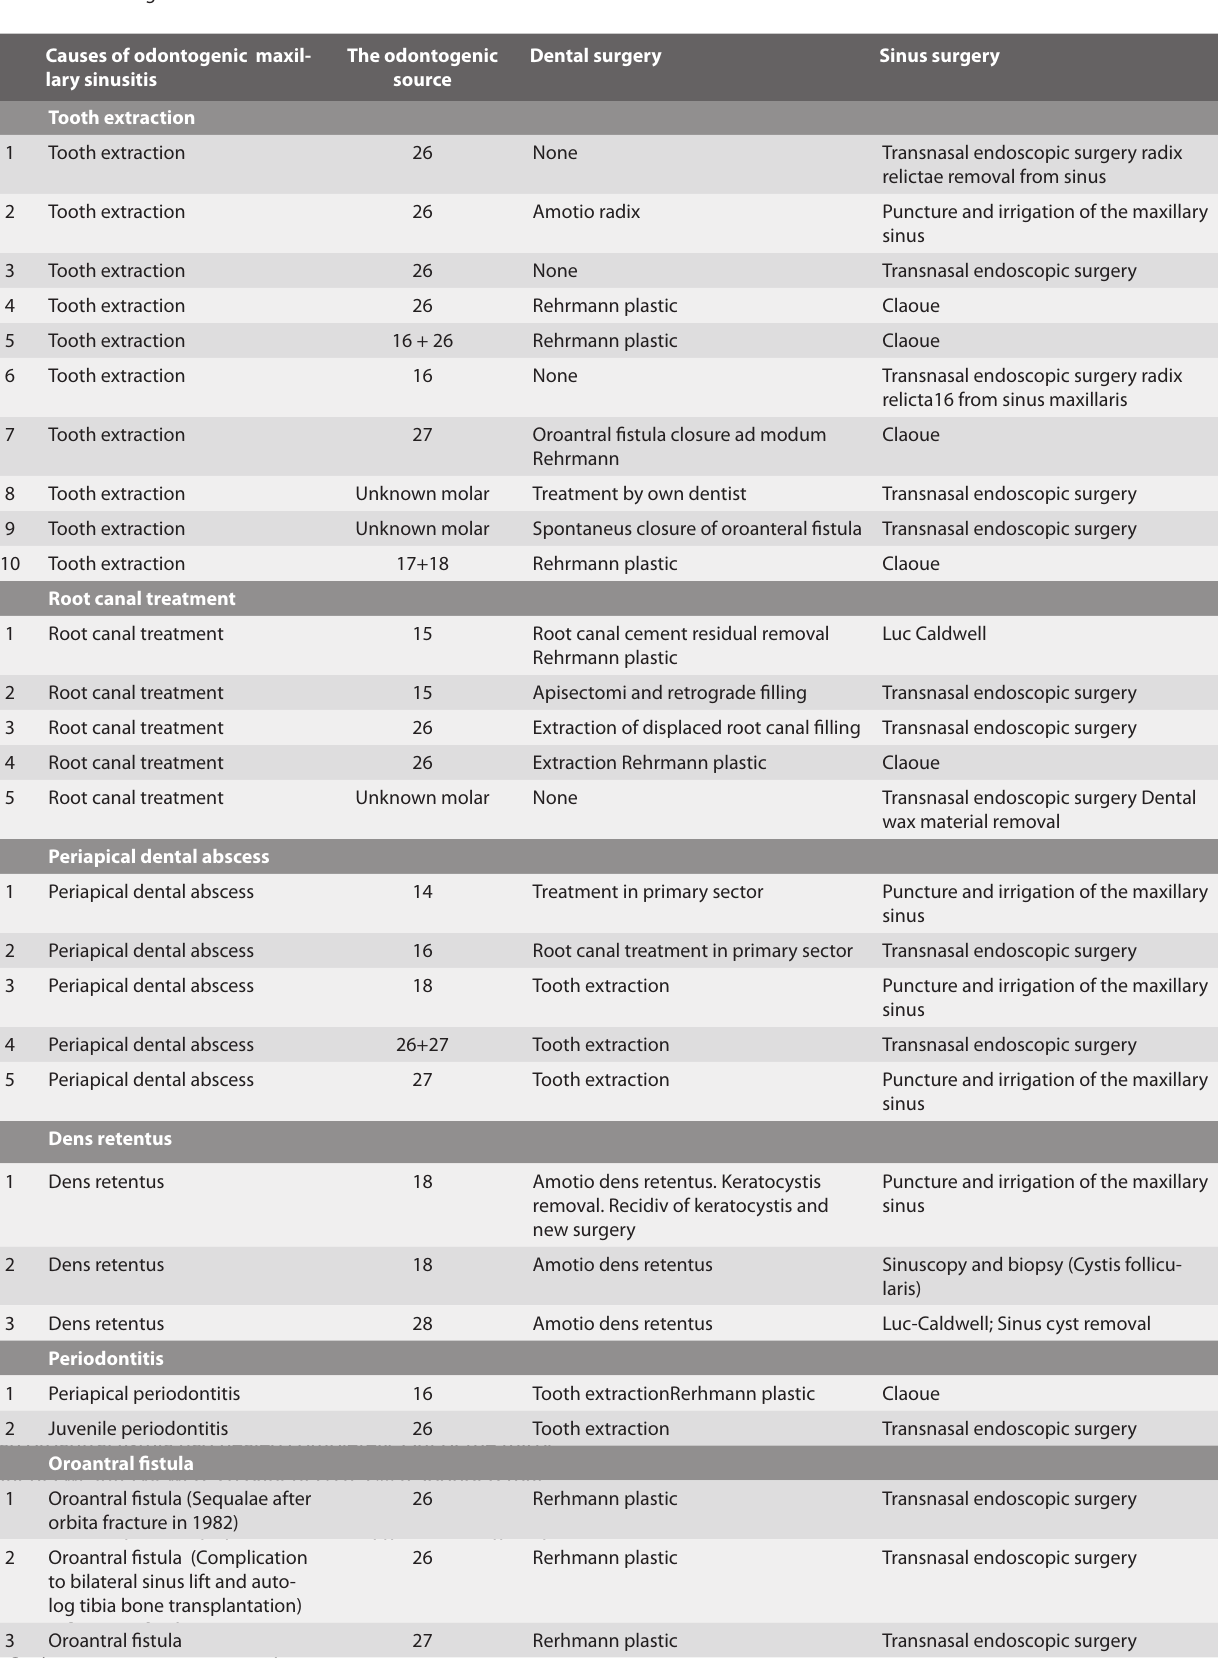
Table 3. The odontogenic sources and the treatment. Causes of odontogenic maxil- lary sinusitis